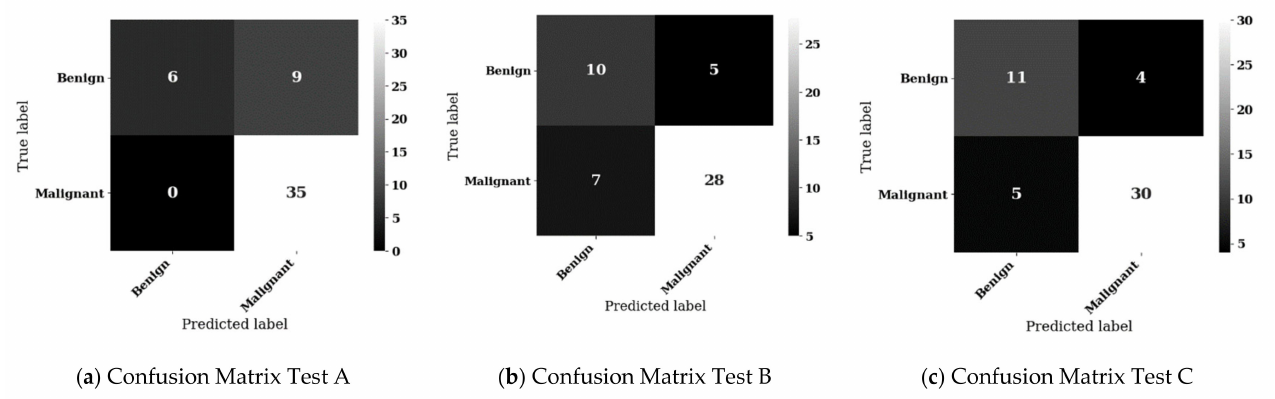
Figure 12. Confusion matrices for experiments A, B, and C using combined LIDC-IDRI and JSRT